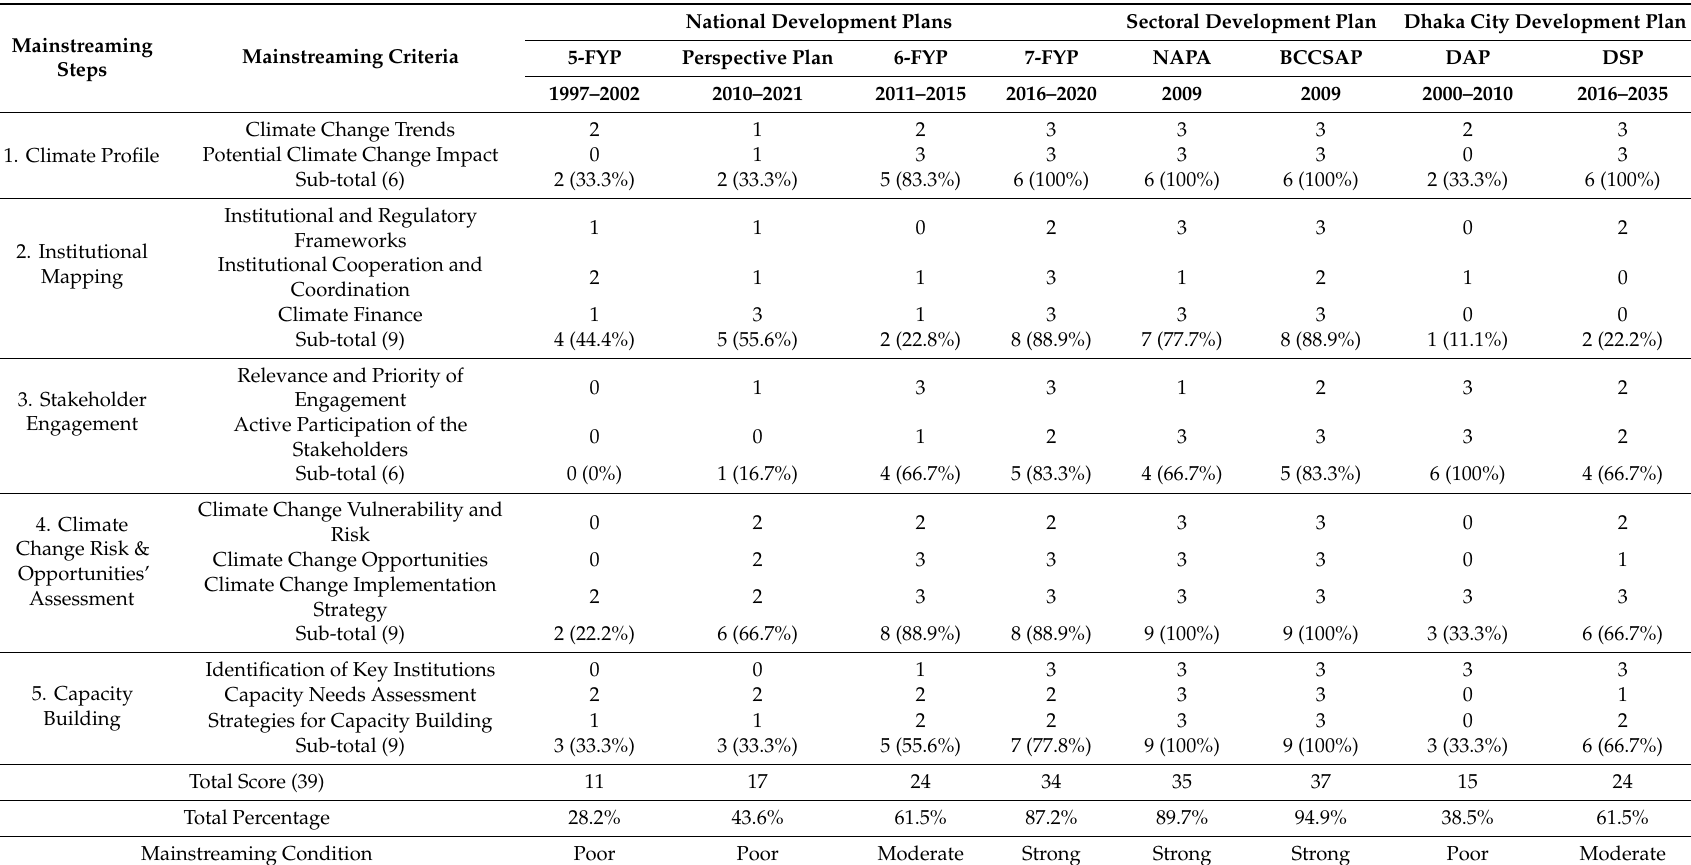
Table 2. The score matrix of selected Sectoral and Dhaka City Development